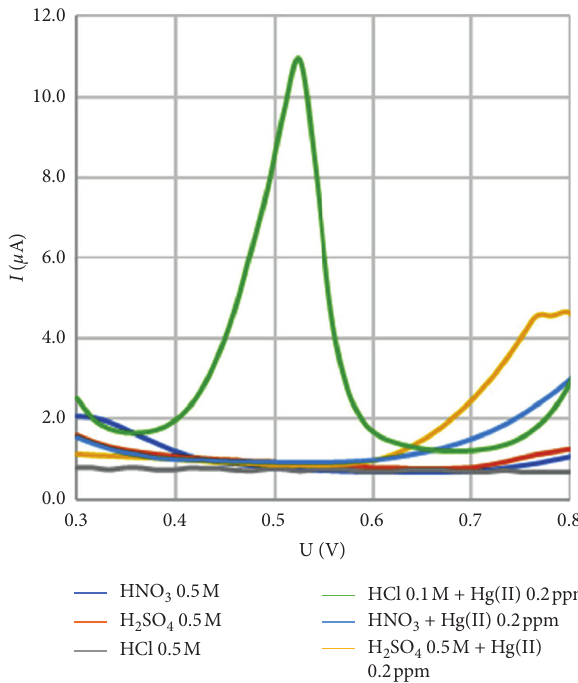
Figure 4: Differential pulse anodic stripping voltammograms of 0.5 moll − 1 HCl, HNO 3 , and H 2 SO 4 and 0.2mgl − 1 Hg 2+ in 0.5 moll − 1 HCl, HNO 3 , and H 2 SO 4 , sweep rate 0.04V s − 1 , pulse amplitude 0.05V, and pulse time